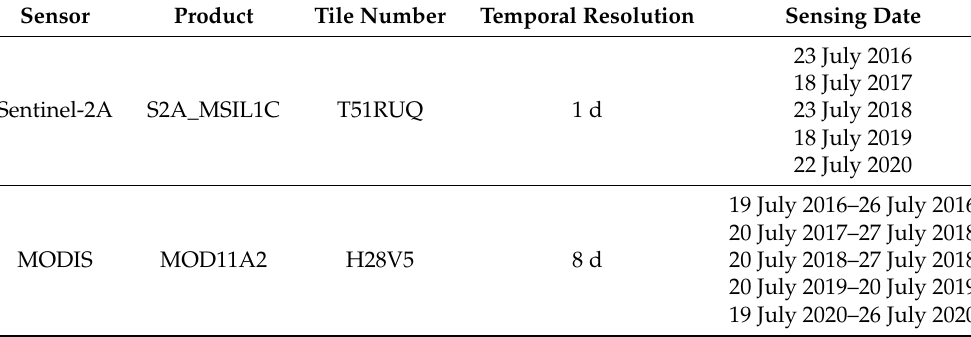
Table 3. The information on raw